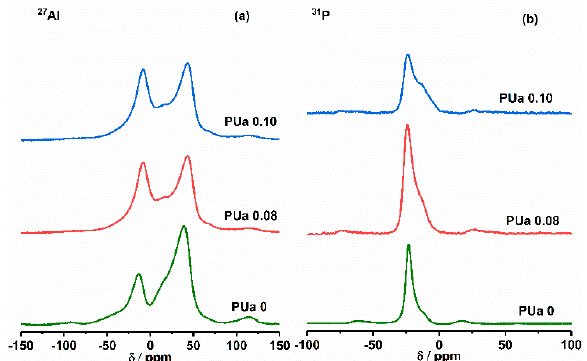
Figure 8. 27 Al ( a ), 31 P ( b ) MAS NMR spectra of the SAPO-34 samples synthesized with and without PUa as mesoporogen.